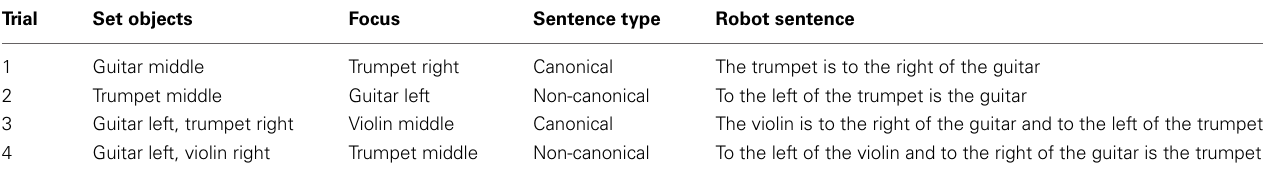
Table 4 | Subset of trials for the scene describer task.